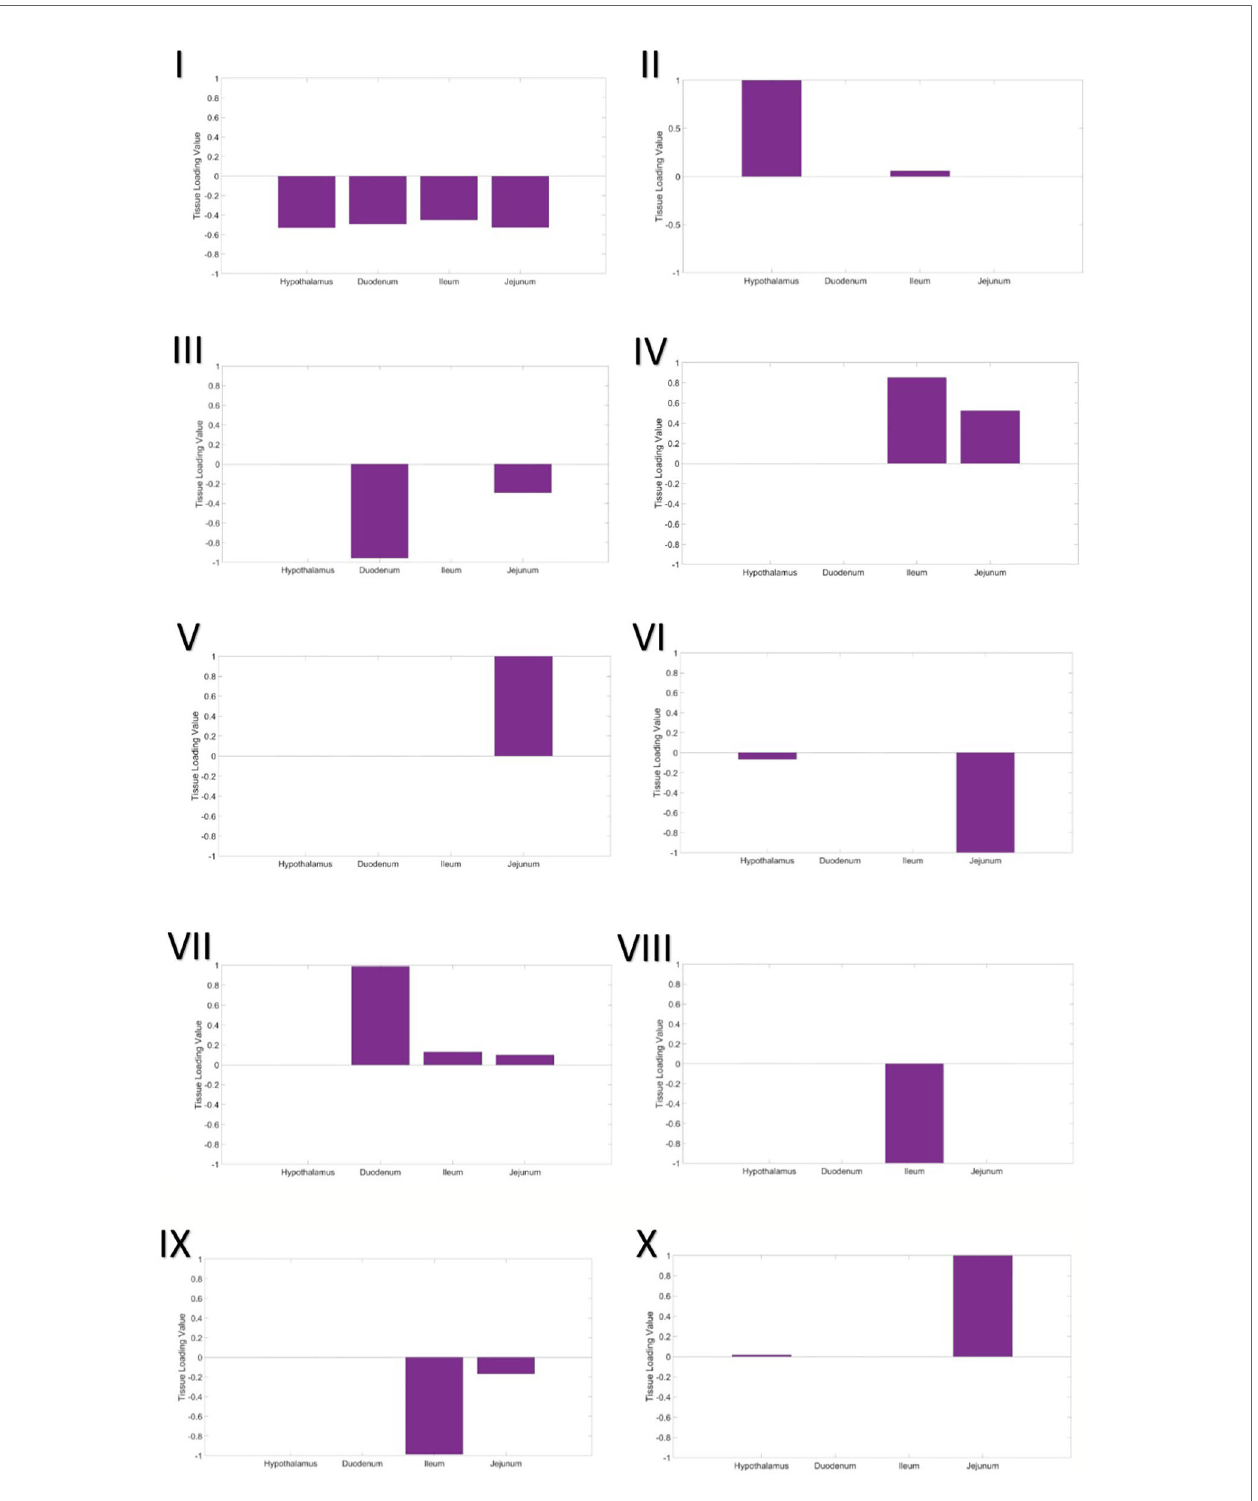
FIGURE 1 | Tissue loading values for Modules I – X from the tensor